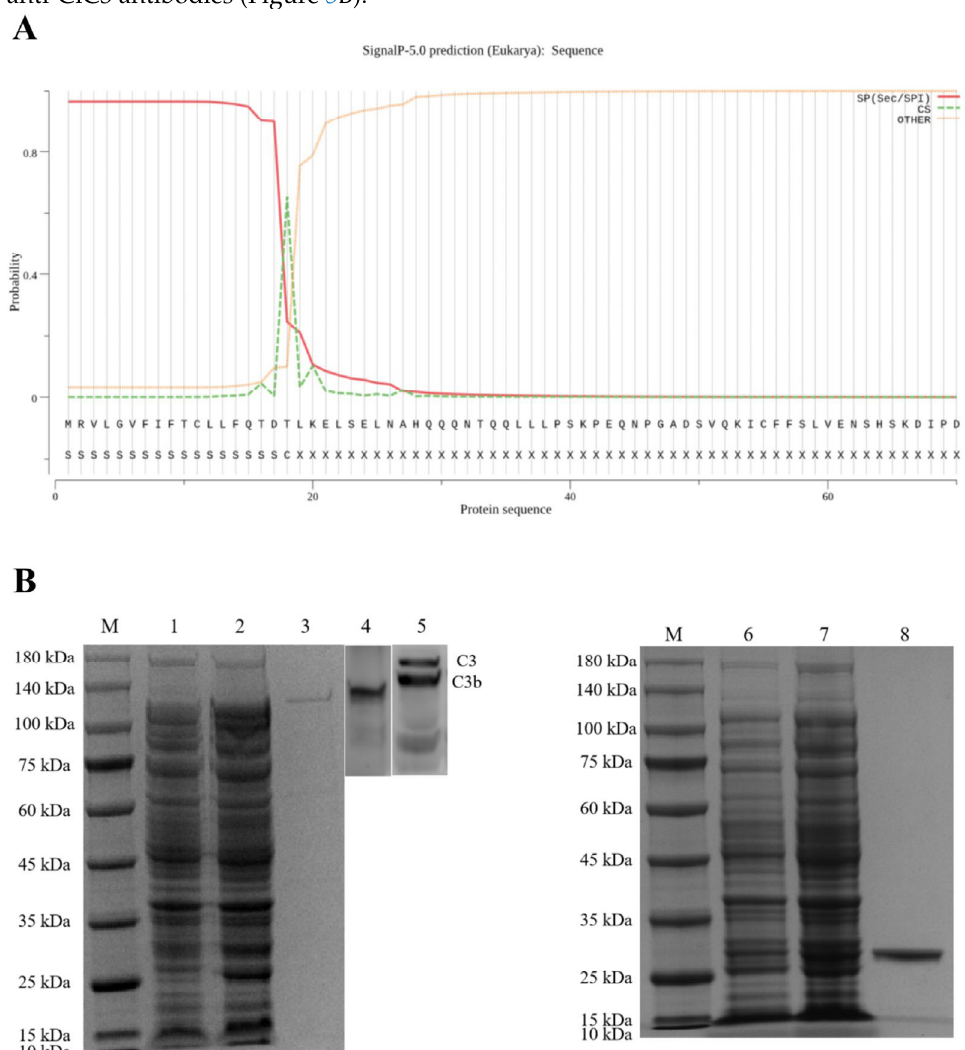
Figure 5. The rCiCFI protein and verification of rabbit anti-CiCFI and -CiC3 polyclonal antibodies. ( A ) The first 18 amino acid residues were predicted to form a signal peptide in the CiCFI protein by using the SignalP-5.0 tool. ( B ) Detection of rCiCFI protein and verification of rabbit anti-CiCFI and -CiC3 polyclonal antibodies. M: Marker; lane 1: the expression products of BL21 (DE3) cells with pGEX-4T-1-CiCFI plasmid without IPTG induction; lane 2: the expression products of BL21 (DE3) cells with pGEX-4T-1-CiCFI plasmid induced by IPTG; lane 3: the purified rCiCFI protein; lane 4 and 5: the verification of rabbit anti-CiCFI and -CiC3 polyclonal antibodies detected by western blot; lane 6 and 7: the expression products of BL21 (DE3) cells with pGEX-4T-1 plasmid without or with IPTG induction; lane 8: the purified rGST